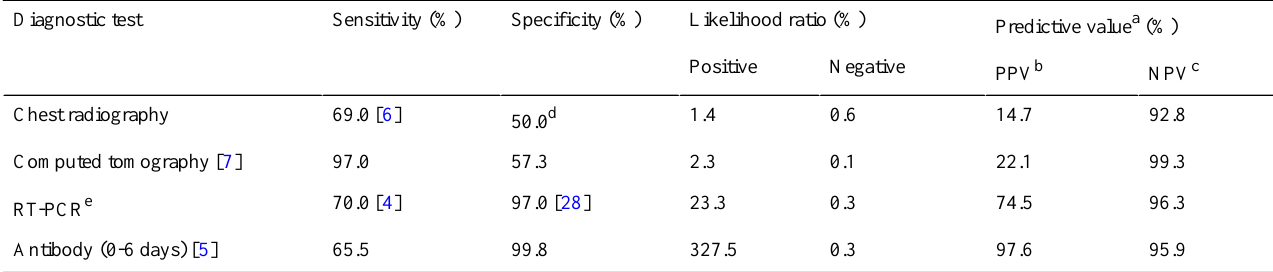
Table 1. Imaging and laboratory diagnostic test statistics for SARS-CoV-2